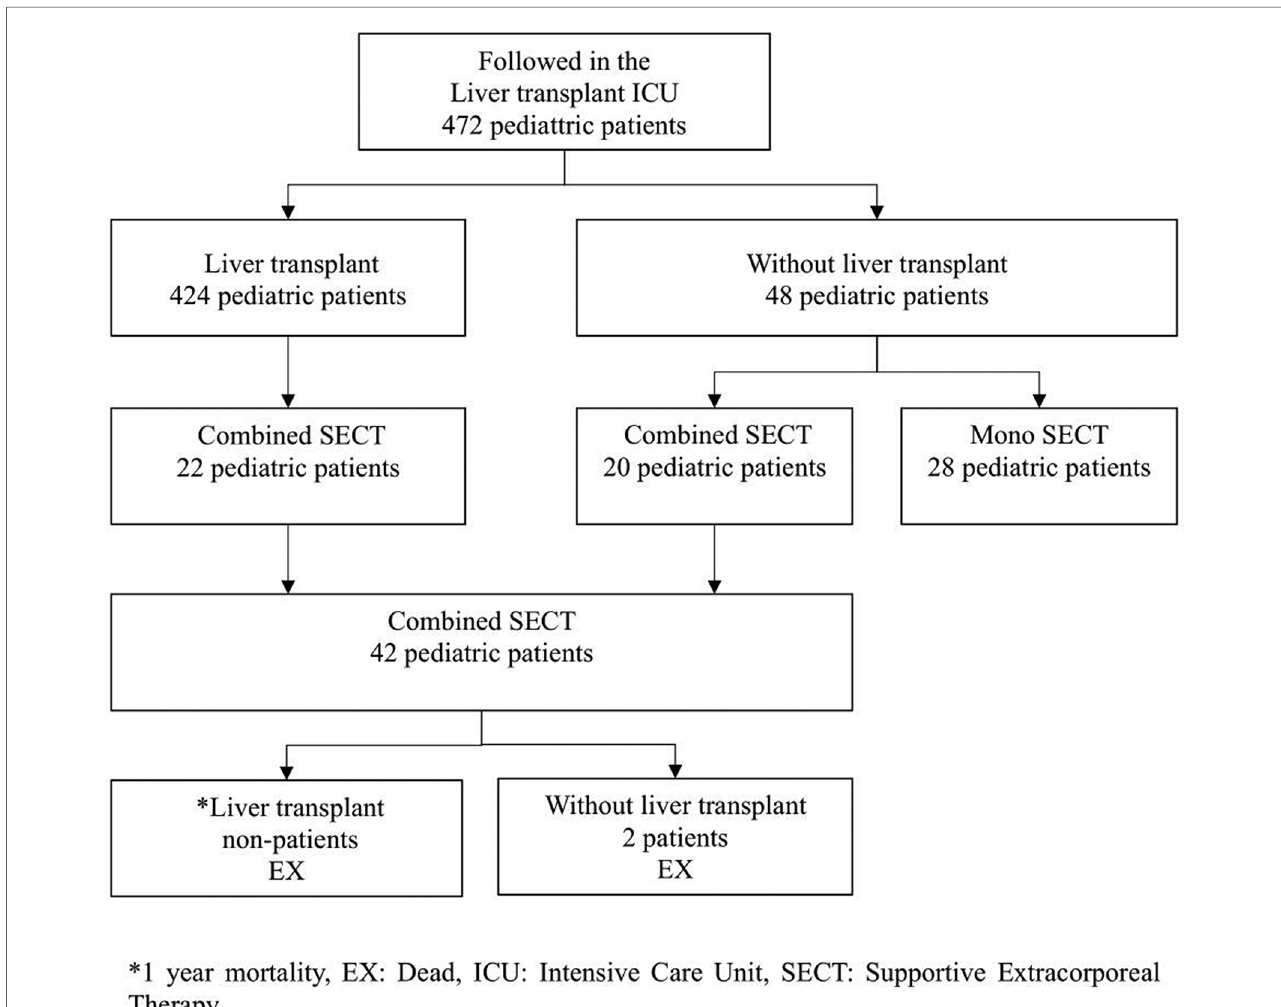
FIGURE 1 Flow diagram of pediatric patients in the